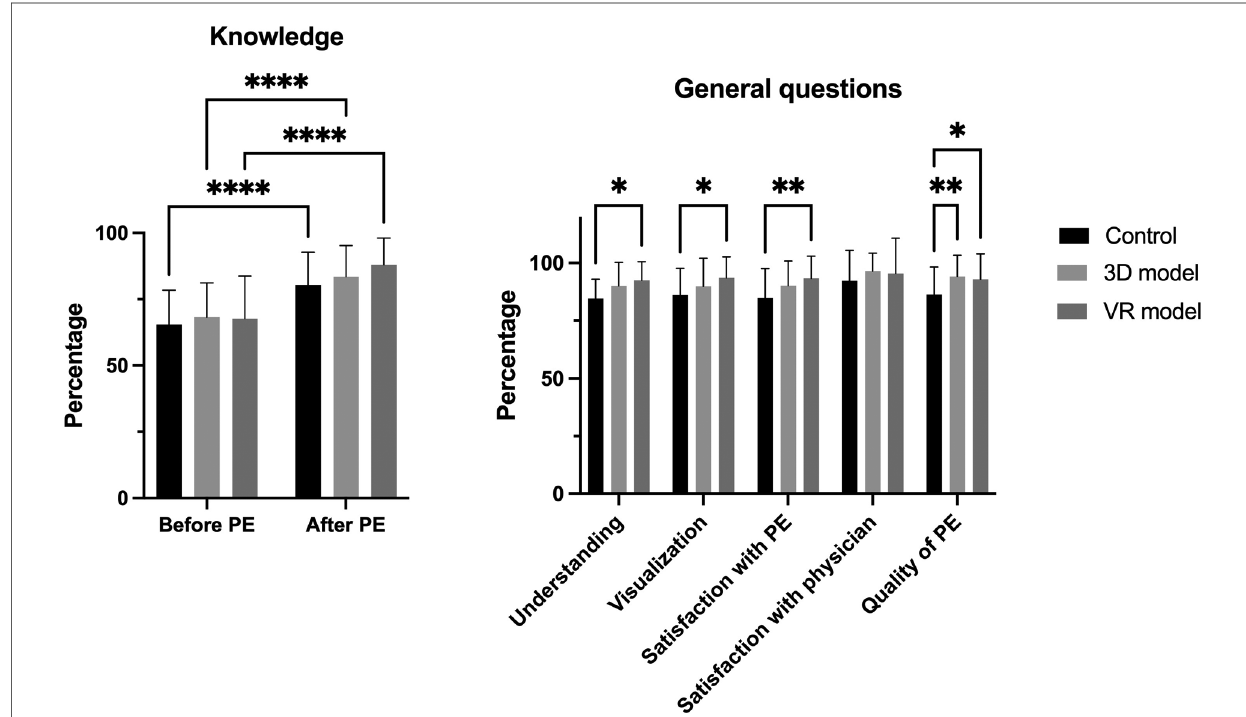
FIGURE 5 Knowledge before and after PE; results of general questions regarding PE . Left: patients ’ procedural knowledge before and after PE. Right: results of general questions about understanding, visualization, satisfaction with PE and physician and quality of PE regarding the three study groups. Data represented as mean±standard deviation. *= p <0.05, **= p <0.005, ****= p